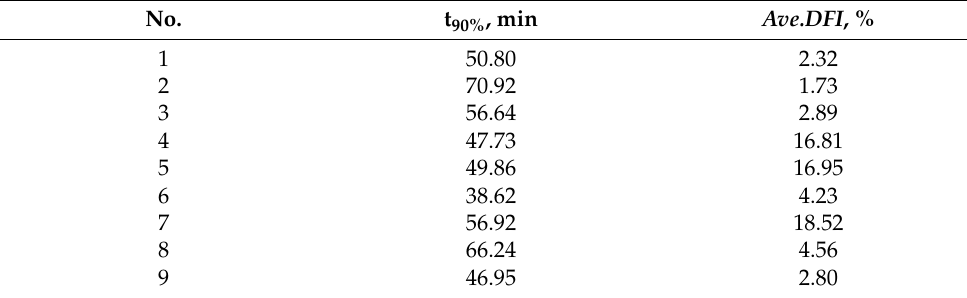
Table 4. The orthogonal experimental result.